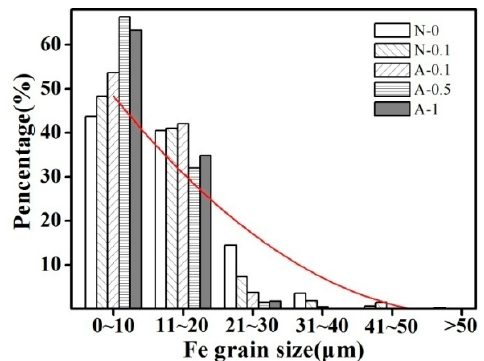
Figure 3. Fe grain size distributions of the various solidification processes.